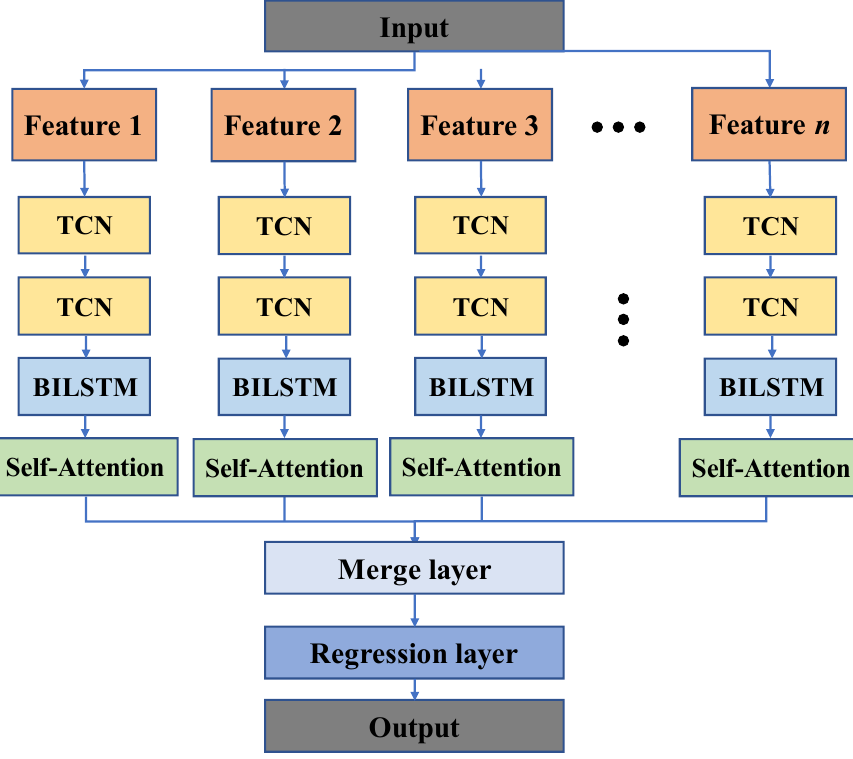
Figure 6. Network structure based on multi-head attention and TCN-BILSTM. Table 1. Network parameters based on TCN-BILSTM and multi-head attention.